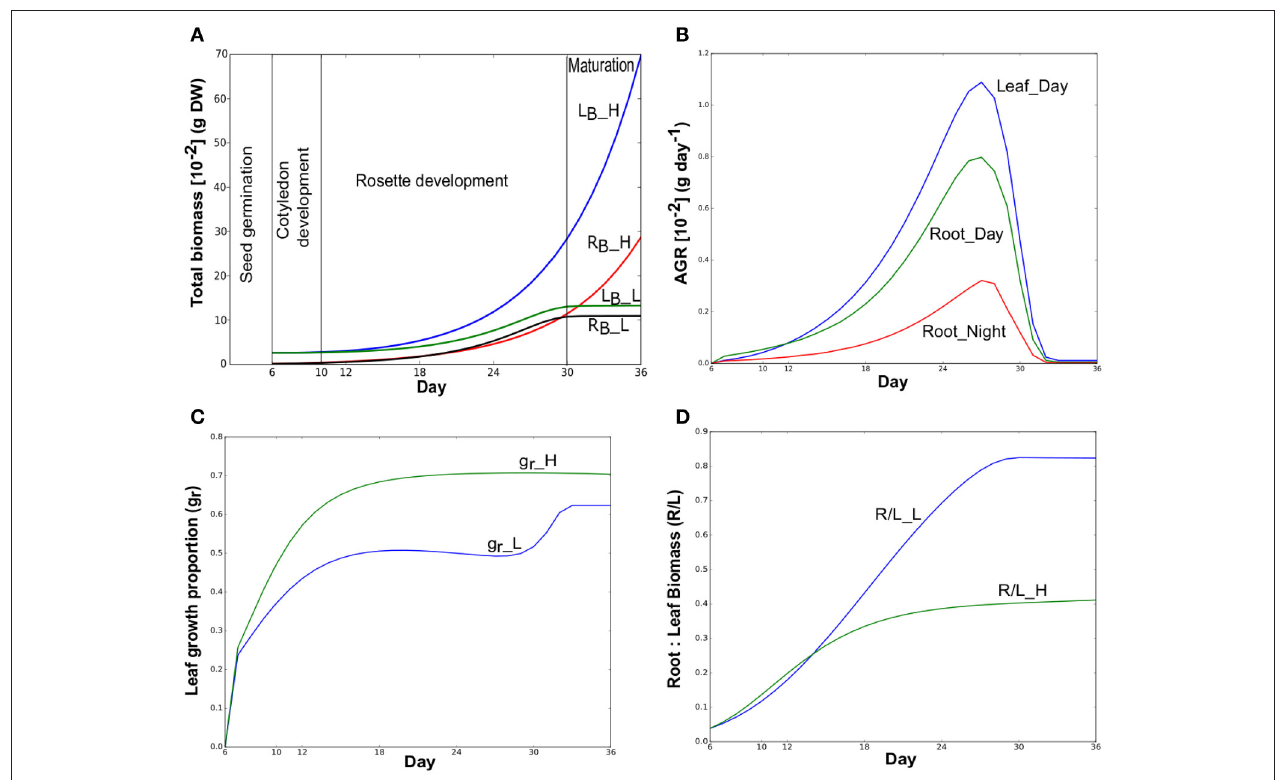
FIGURE 2 | (A) Simulated total biomass (dry weight) accumulation of Arabidopsis thaliana over time in a 30-day period. Total biomass of leaf (L B ) and root (R B ) under N high (_H) and N low (_L) are shown here. These suffixes will be used to distinguish reactions in N high and N low throughout this manuscript. Simulations were started with the cotyledon development (hypocotyl and cotyledon development) stage of Arabidopsis at day 6 that continues upto day 10. Rosette development (leaf and root development) begins from day 11 and completed on day 30 when maturation starts. Days were shown from the day after sowing in all figures. (B) Absolute growth rates (AGR) of individual tissues at Day (light) and Night (dark) under N low . (C) Leaf growth proportion (g r ) under N high and N low . (D) Root:leaf (R B :L B ) biomass ratio under N high and N low .